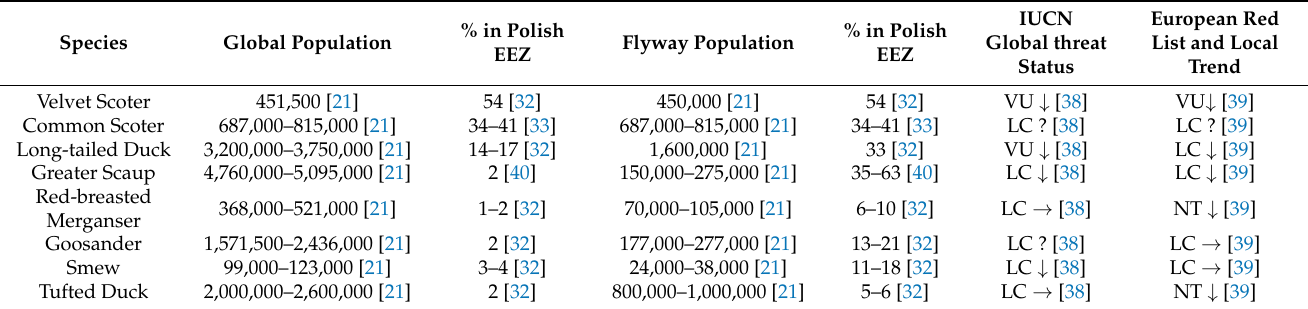
Table 1. Numbers of waterbirds wintering in the Polish EEZ of the Baltic Sea compared to the numbers in the flyway and global populations. Values calculated based on the maximum numbers recorded in the Polish EEZ in the non-breeding period from 2011 to